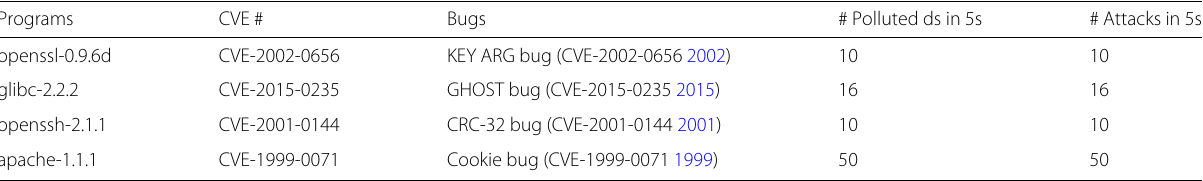
Table 2 Justification of Effectiveness in